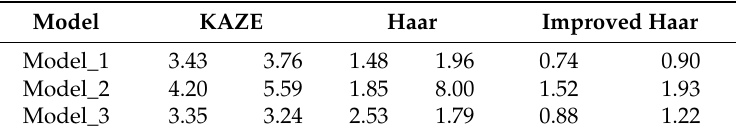
Table 2. Comparison of circle radii average pixel errors under different illuminations by three matching algorithms.